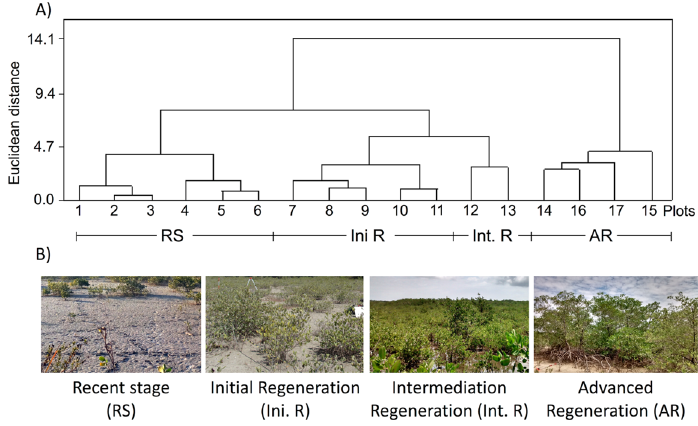
Figure 2. ( A ) Cluster analysis using Euclidian distance with the biophysical parameters: average canopy height, DBH and basal area; ( B ) Different mangrove regeneration stages observed in the field.